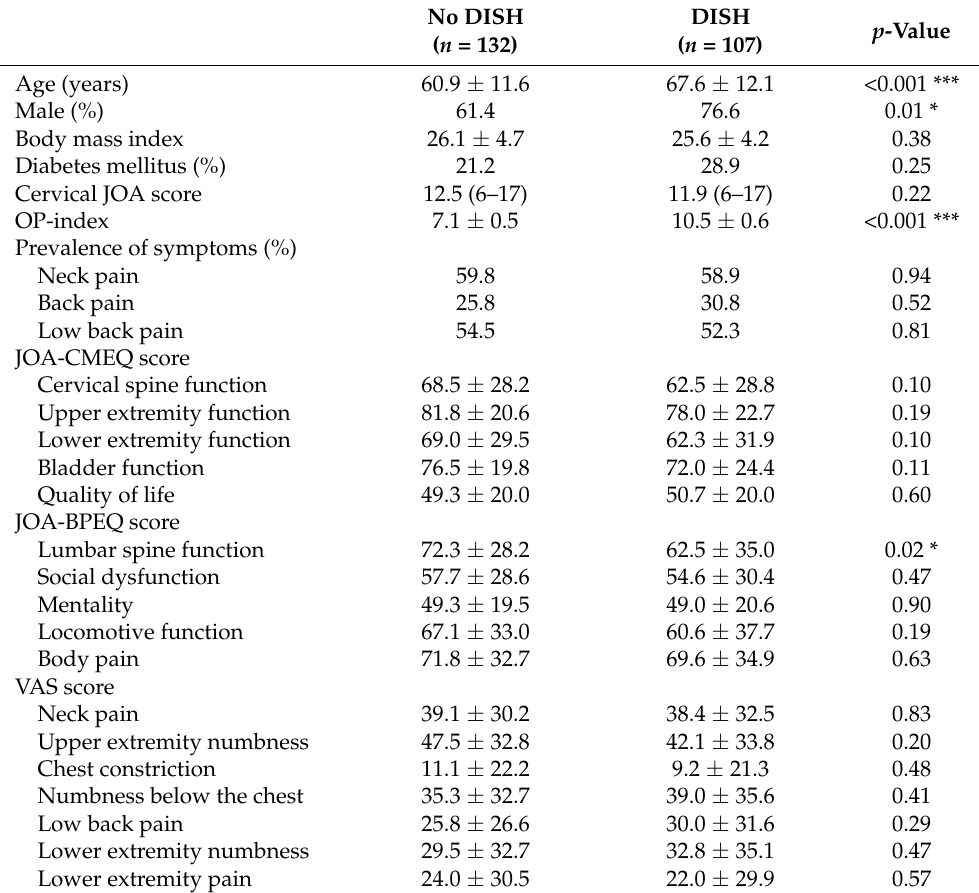
Table 1. Demographic and clinical data for patients with OPLL according to presence or absence of